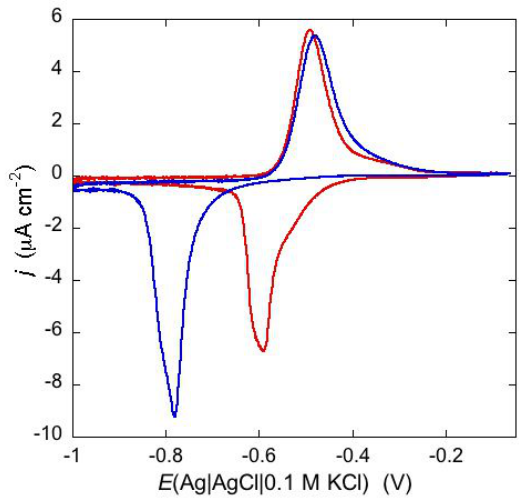
Figure 11. Cyclic voltammograms of a DPTL/DOPC tBLM in aqueous 0.1 M KCl containing 0.3 μ M gramicidin, at a scan rate of 10 mV s − 1 , before (blue curve) and after stabilization (red